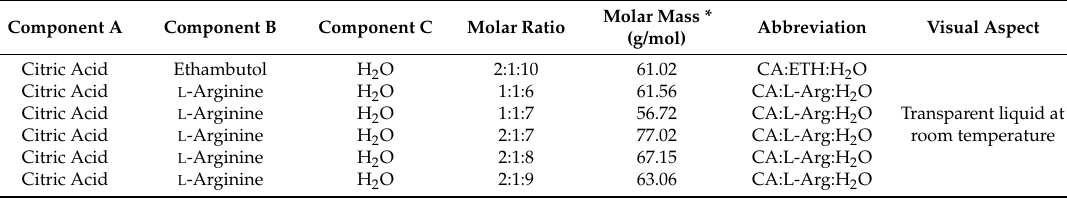
Table 4. Different THEDES